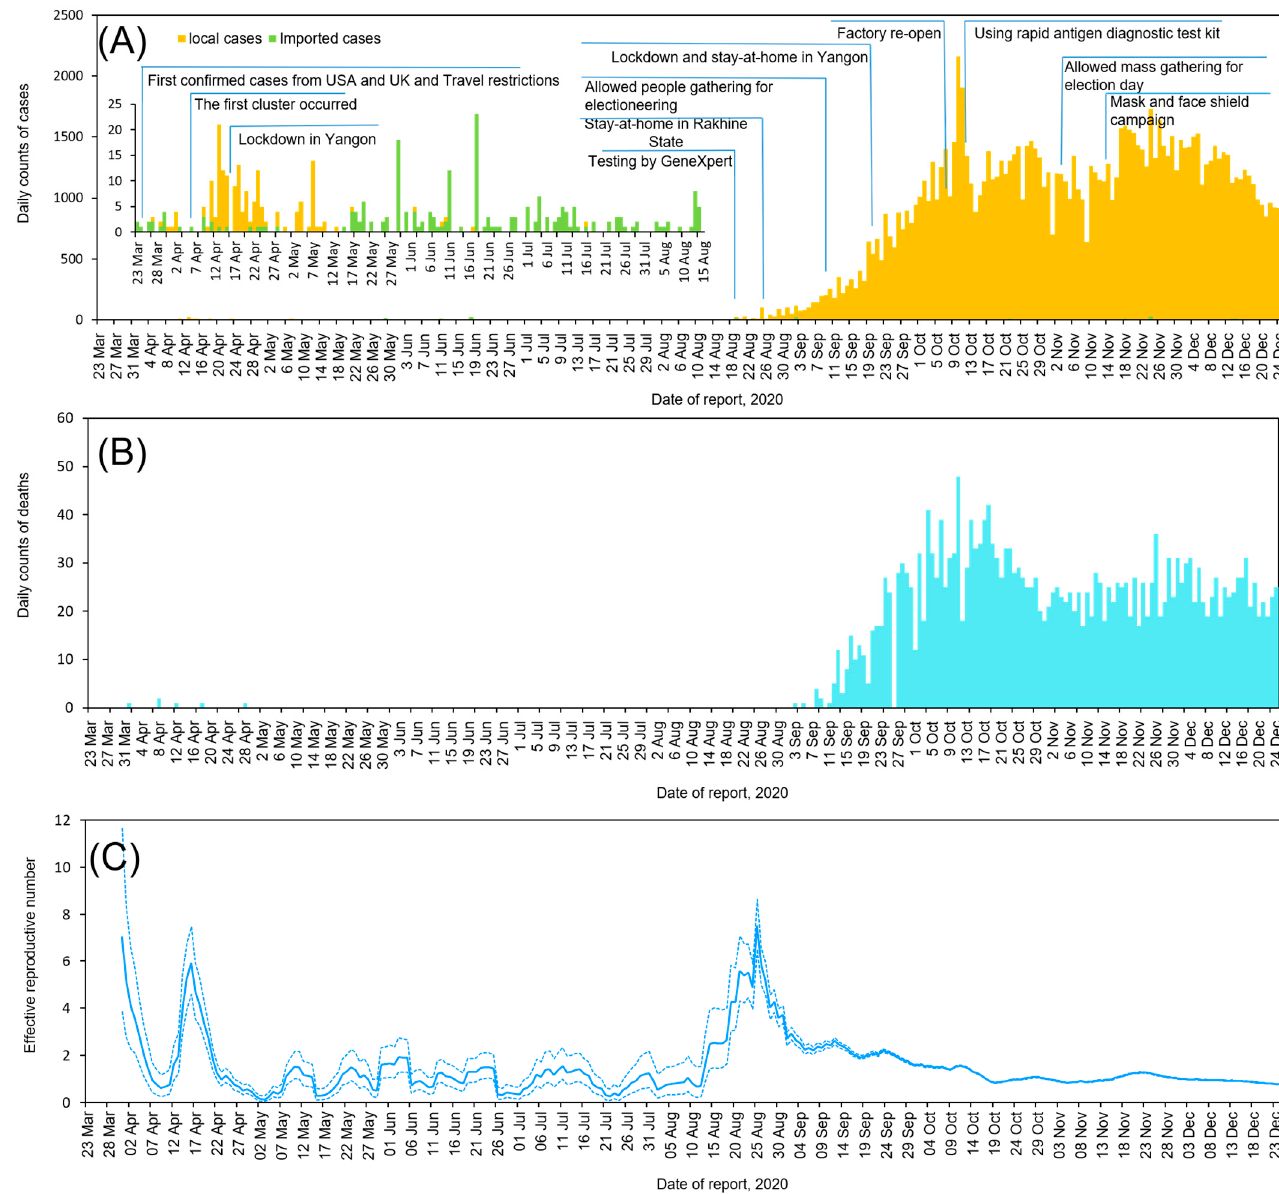
Figure 2. The epidemic situation of coronavirus disease-2019 (COVID-19) in Myanmar from 23 March to 30 December 2020. ( A ) The daily number of laboratory-confirmed cases by reporting date colored as yellow and green and timeline of events. ( B ) The daily number of reported death cases by reporting date colored as light blue. ( C ) Estimated daily reproductive number ( R t ). Solid blue indicates time-varying R t during the study period. Dashed blue lines show95% credible intervals.